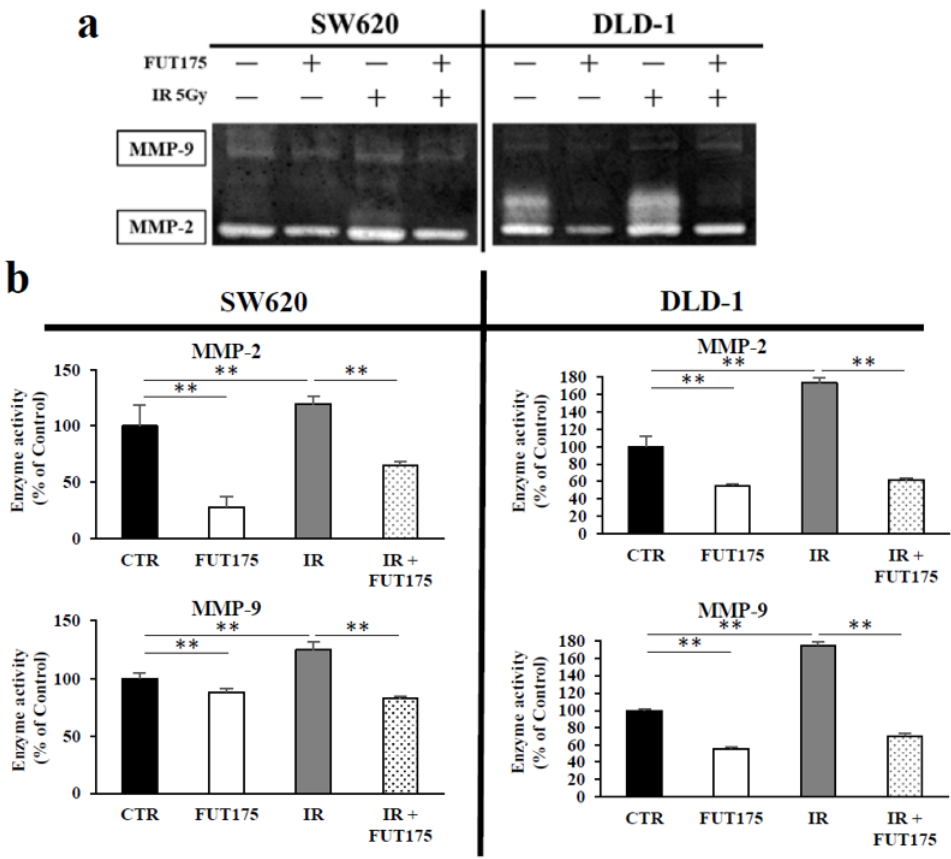
Figure 6. Nafamostat mesilate (FUT175) inhibits the enzymatic activity of matrix metalloproteinase (MMP)-2 and MMP-9 in colorectal cancer (CRC) cells. ( a ) The cells were treated with FUT175 (80 µ g/mL) for 3 h prior to irradiation (5 Gy). At 24 h of incubation after the treatment, the conditioned media were measured. Gelatin zymography of CRC cells after 5 Gy ionizing radiation (IR) (or 0 Gy, control) showed that treatment with FUT175 for 24 h decreased the activity of MMP-2 and MMP-9. ( b ) The cells were treated with FUT175 (80 µ g/mL) for 3 h prior to irradiation (5 Gy). At 24 h of incubation after the treatment, the conditioned media were measured. Quantitative MMP activity assays showed that the enzymatic activity of MMP-2 and MMP-9 was significantly lower in the combination groups than in the IR groups (MMP-2: SW620, 65.1% ± 3.0 vs. 119.5% ± 6.6 and DLD-1, 61.6% ± 1.6 vs. 173.2% ± 6.0, p < 0.01; MMP-9: SW620, 83.1% ± 1.9 vs. 124.8% ± 6.9 and DLD-1, 70.7% ± 2.8 vs. 174.6% ± 4.4, p < 0.01). **, p < 0.01. All experiments were performed in triplicate. The expression of MMP-2 and MMP-9 was also analyzed by Western blot analyses: no significant differences were observed between the control and FUT175 group (Figure 7a). On the other hand, when FUT175 was added to cell extracts from CRC cells, the enzymatic activity of MMP-2 and MMP-9 decreased in a dose-dependent manner (Figure 7b). These results suggest that FUT175 suppresses the IR-induced invasion ability of CRC cells through direct inhibition of the enzymatic activity of MMP-2 and